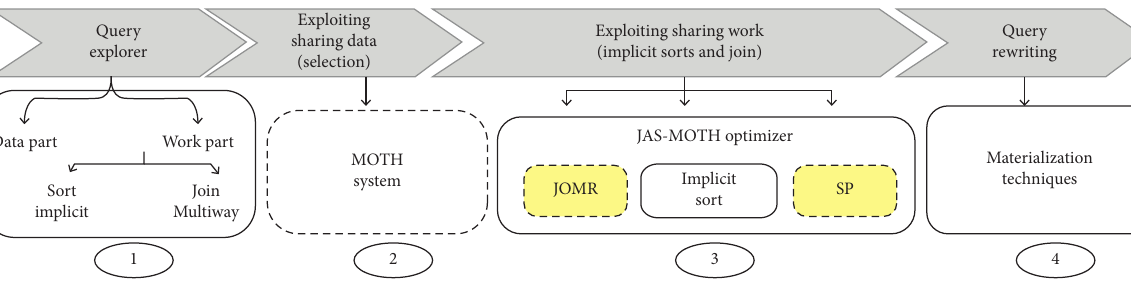
Figure 8: The J-MOTH multiquery optimizer phases for multiway joins.